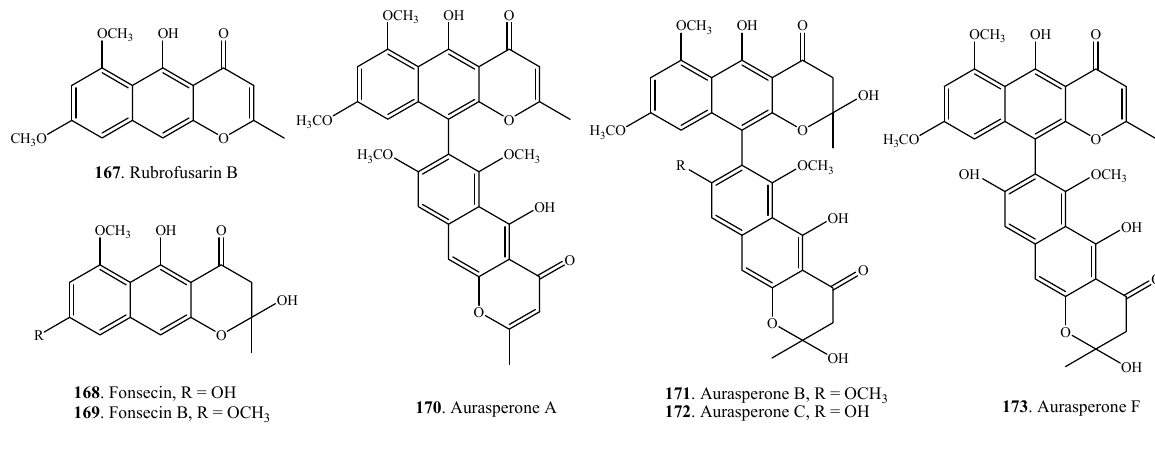
Figure 9. Naphthopyranones isolated from Alternaria fungi.